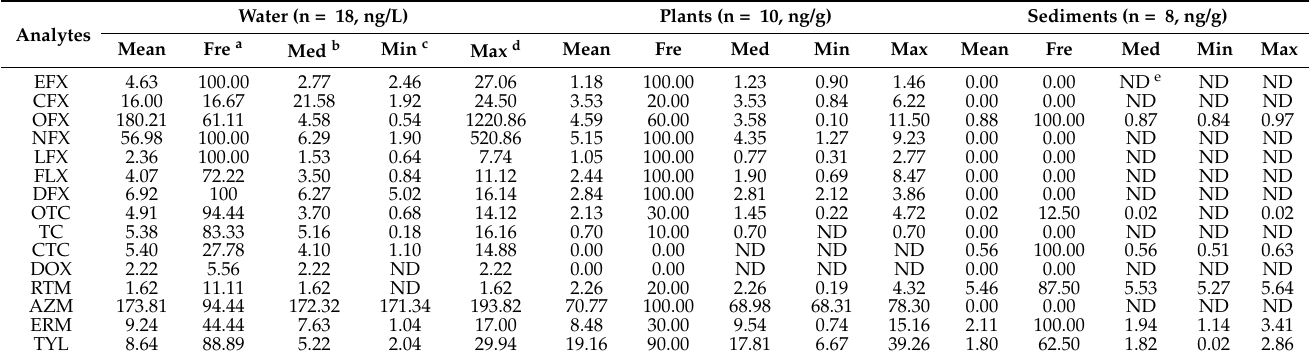
Table 2. Concentrations of antibiotics in water, plants, and sediments in the